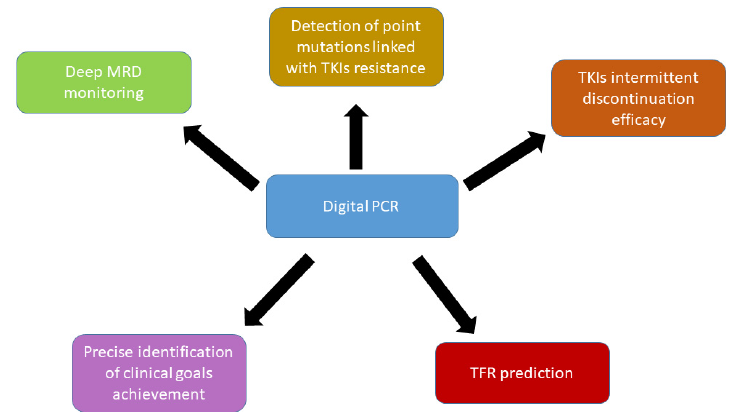
Figure 3. Possible further application of dPCR in adult CML context.